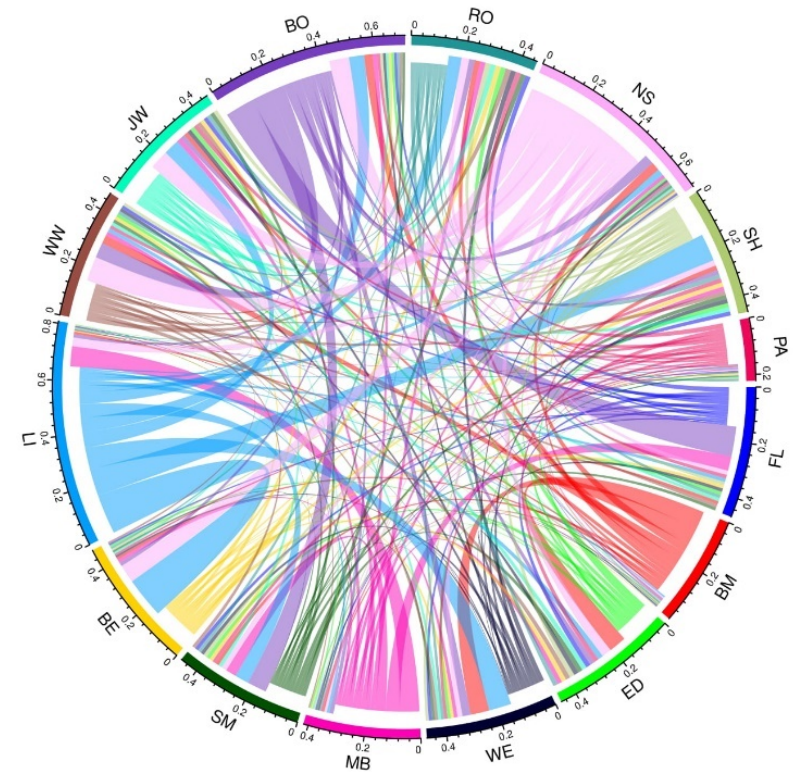
Figure 3. Circos plot of inferred contemporary migration rates (per last generation) between sub- populations of yellow-bellied toads based on 10 microsatellites. Plot corresponds to the detected migration (full values from BayesAss3 are provided in Supplementary Materials Table S5). Width of the curves indicates the amount of migration, according to the scale, going from one subpopulation into the